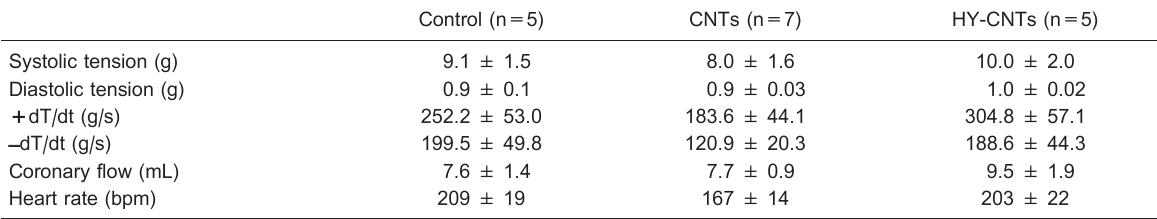
Data are reported as means±SE. There were no significant differences among groups (P . 0.05, one-way ANOVA followed by Newman-Keuls post-test). CNTs: carbon nanotubes; HY-CNTs: carbon nanotubes associated with sodium hyaluronate; ±dT/dt: